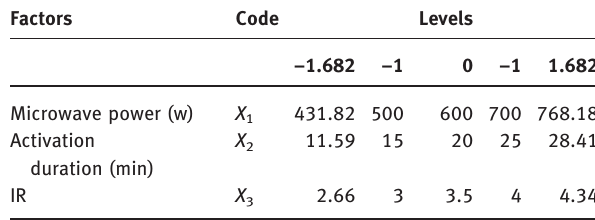
Table 1: Independent variables and their levels used for central composite rotatable design.